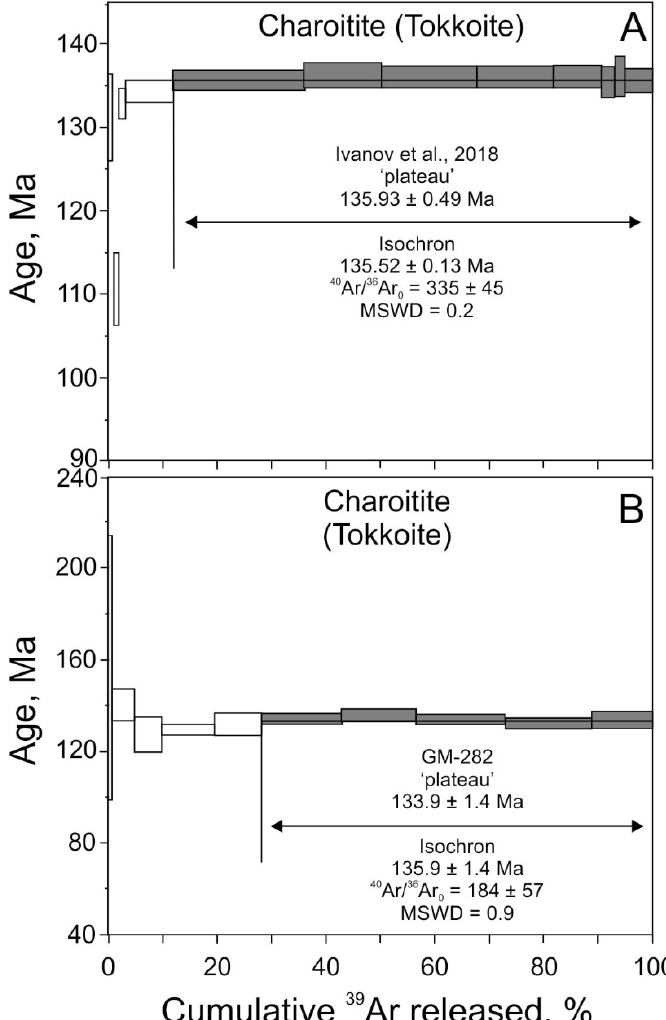
Figure 10. Argon release spectra for two different crystals of tokkoite ( K 2 Ca 4 Si 7 O 17 (O,OH,F) 4 ) of a museum charoitite sample: ( A ) Obtained in [40] and ( B ) in this study. For the sample dated in this study, the isochron age is preferred due to the non-atmospheric trapped argon. Steps used for calculation of plateau and isochron age values are shadowed.